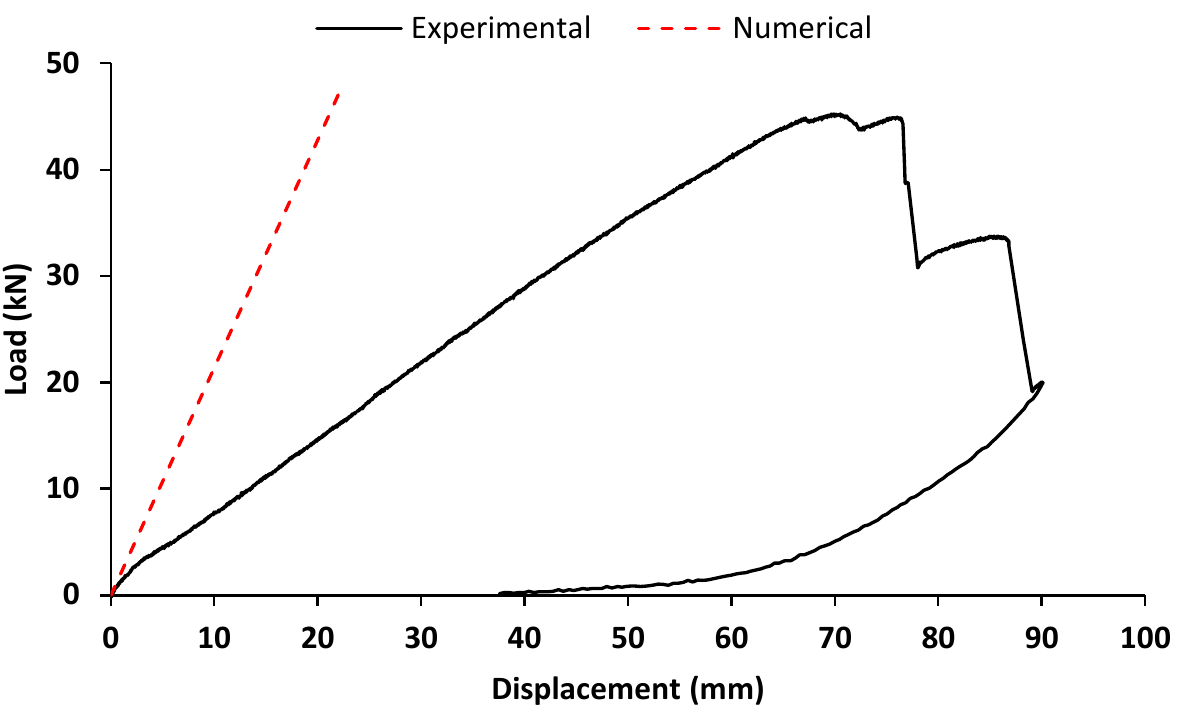
Figure 15. GFRP portal frame load–displacement behaviour: experimental and numerical curves.